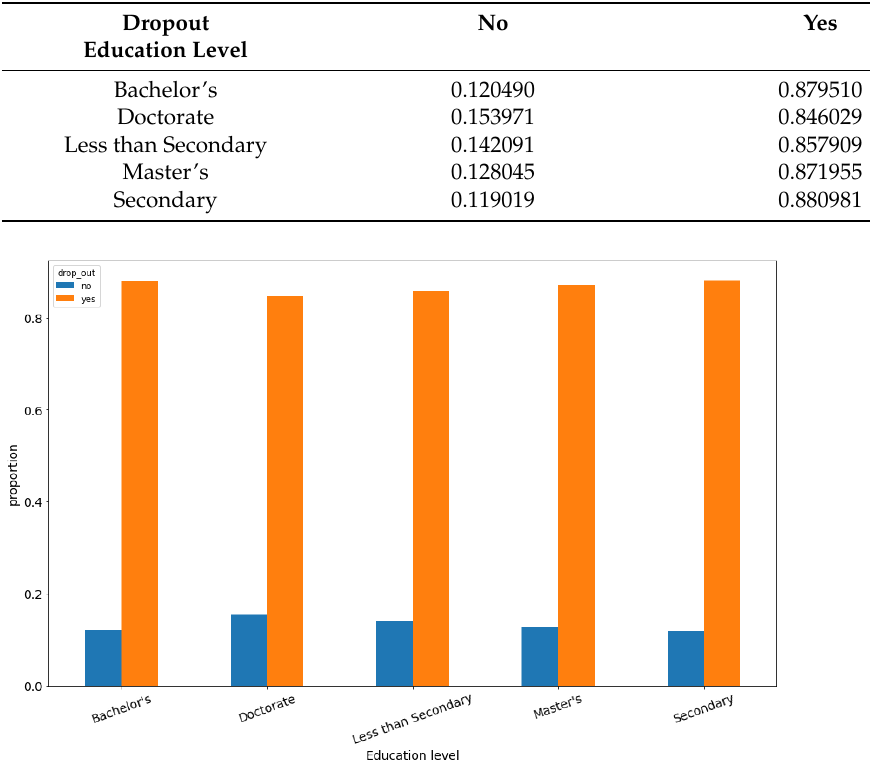
Figure 7. Dropout rate among students with different academic qualifications.